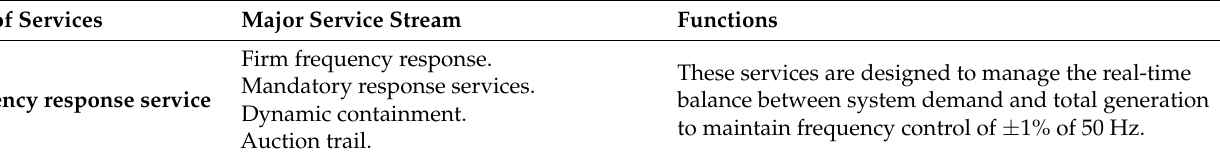
Table 5. Balancing services in the United Kingdom